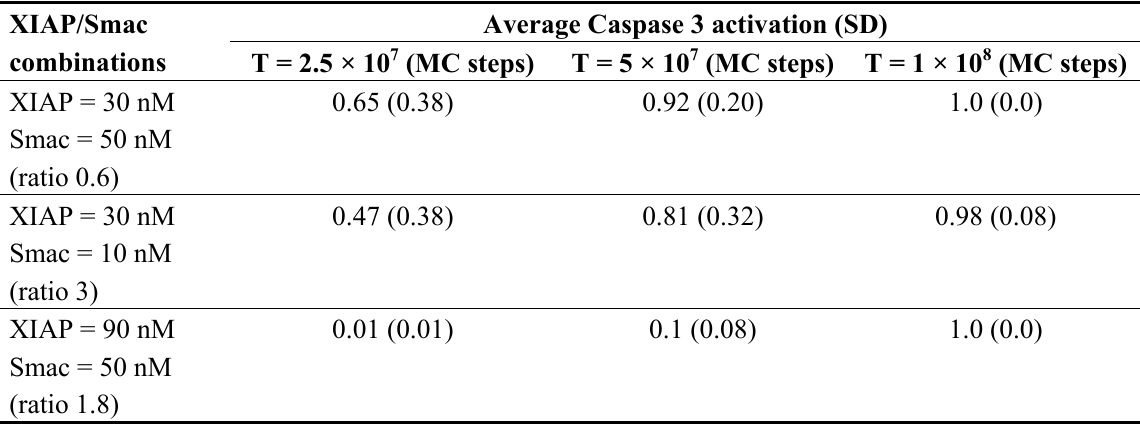
Table 1. Caspase 3 activation for different XIAP/Smac ratios and at different time-points. Active caspase 8 = 1 nM. Data normalized to half-maximal caspase 3 (= 50 nM) activation is shown. Data is averaged over 64 single cells (MC runs) for XIAP = 30 nM and over 10 single cell runs for XIAP = 90 nM.